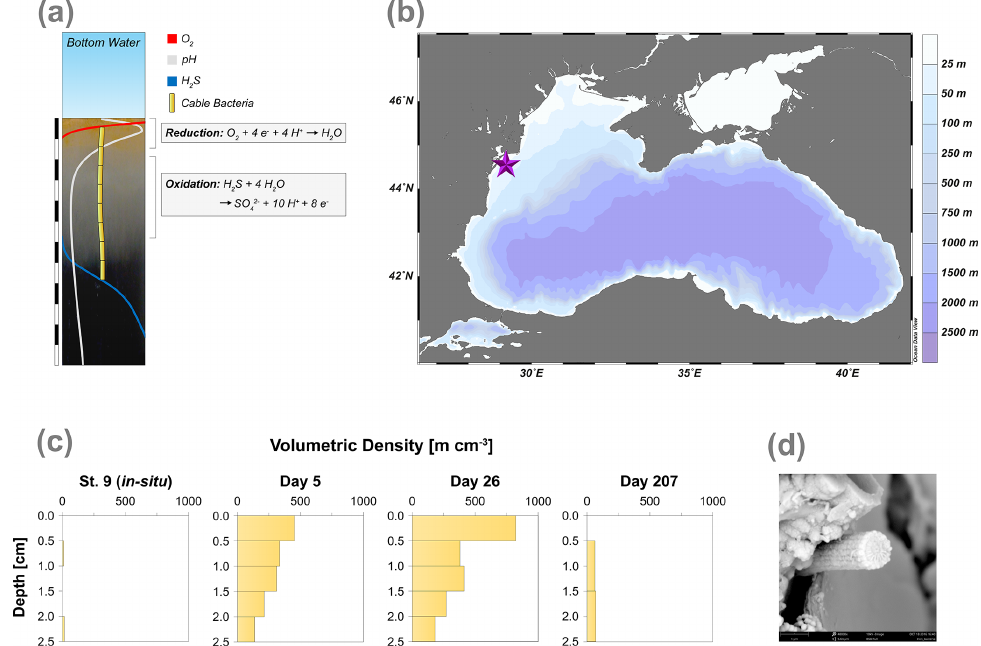
Figure 1. (a) Geochemical pore water fingerprint typical for cable bacteria activity. This fingerprint is defined by a distinct pH profile (light grey line) and a sub-oxic zone that is devoid of O 2 (red line) and H 2 S (blue line). The cable bacteria filaments are depicted in yellow. In the background, the sediment core photograph, taken 278d after the start of the experiment, shows a distinct colour zonation where (1) the oxic zone displays an orange colour, (2) the suboxic zone has a grey colour and (3) the sulfidic zone has a black colour. The scale bar denotes a distance of 6cm, with 0.5cm intervals. (b) Bathymetric map of the Black Sea. The purple star indicates the location of our study site (44 ◦ 34.93 (cid:48) N, 29 ◦ 11.38 (cid:48) E), which was sampled with research vessel (R/V) Pelagia in September 2015. Further details are provided in Lenstra et al. (2019). (c) Volumetric density of cable bacteria (mcm − 3 ) in the top 2.5cm of the sediment, for in situ and for three time points during the incubation experiment. (d) Scanning electron microscopy (SEM) image of a cable bacteria filament that was extracted from the surface sediment after